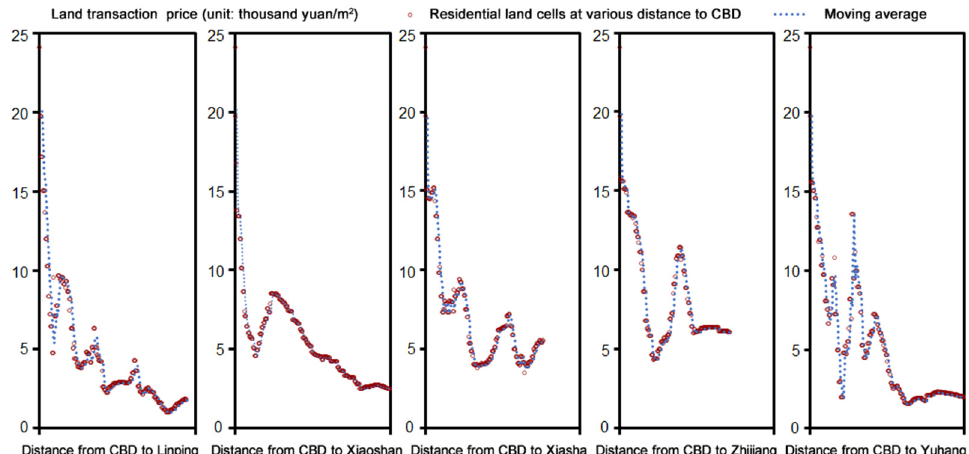
Figure 9. Variations of Hangzhou’s residential land prices from the urban center to sub-centers during 2000–2010.